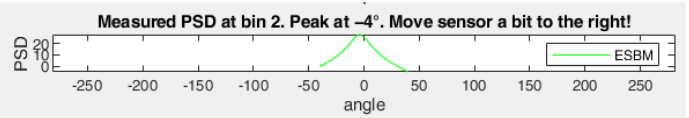
4° relative to the −